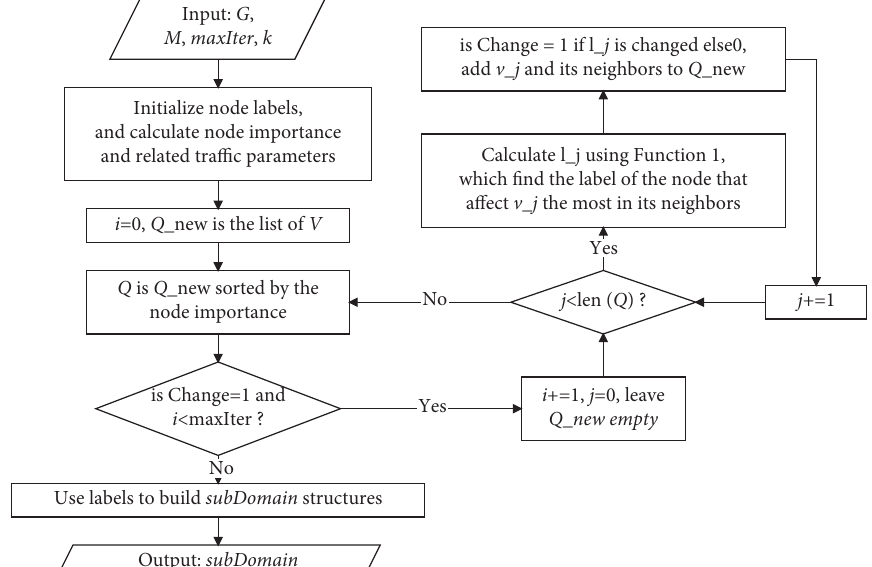
Figure 3: The flow diagram of Algorithm